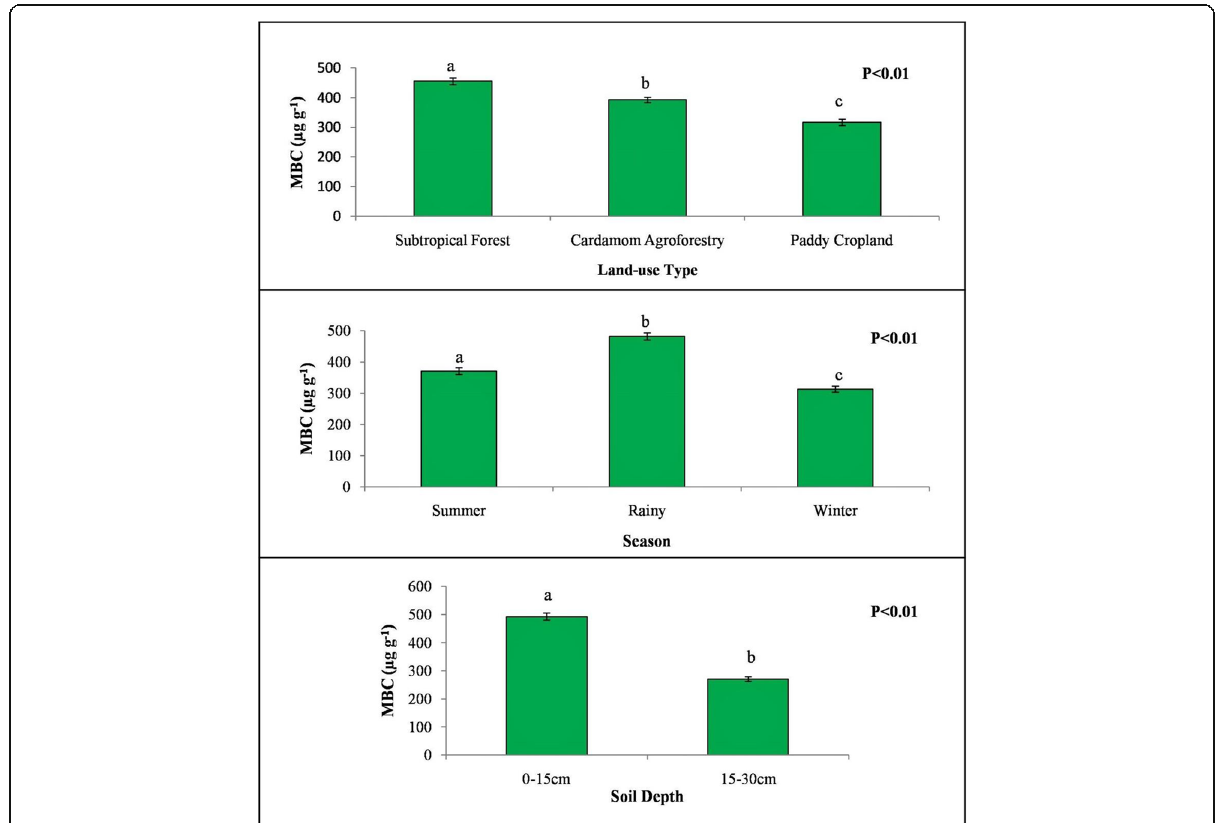
Fig. 3 Variance of microbial biomass carbon ( μ g g − 1 ) due to land-use type, season, and soil depth (average value of 2 years ±